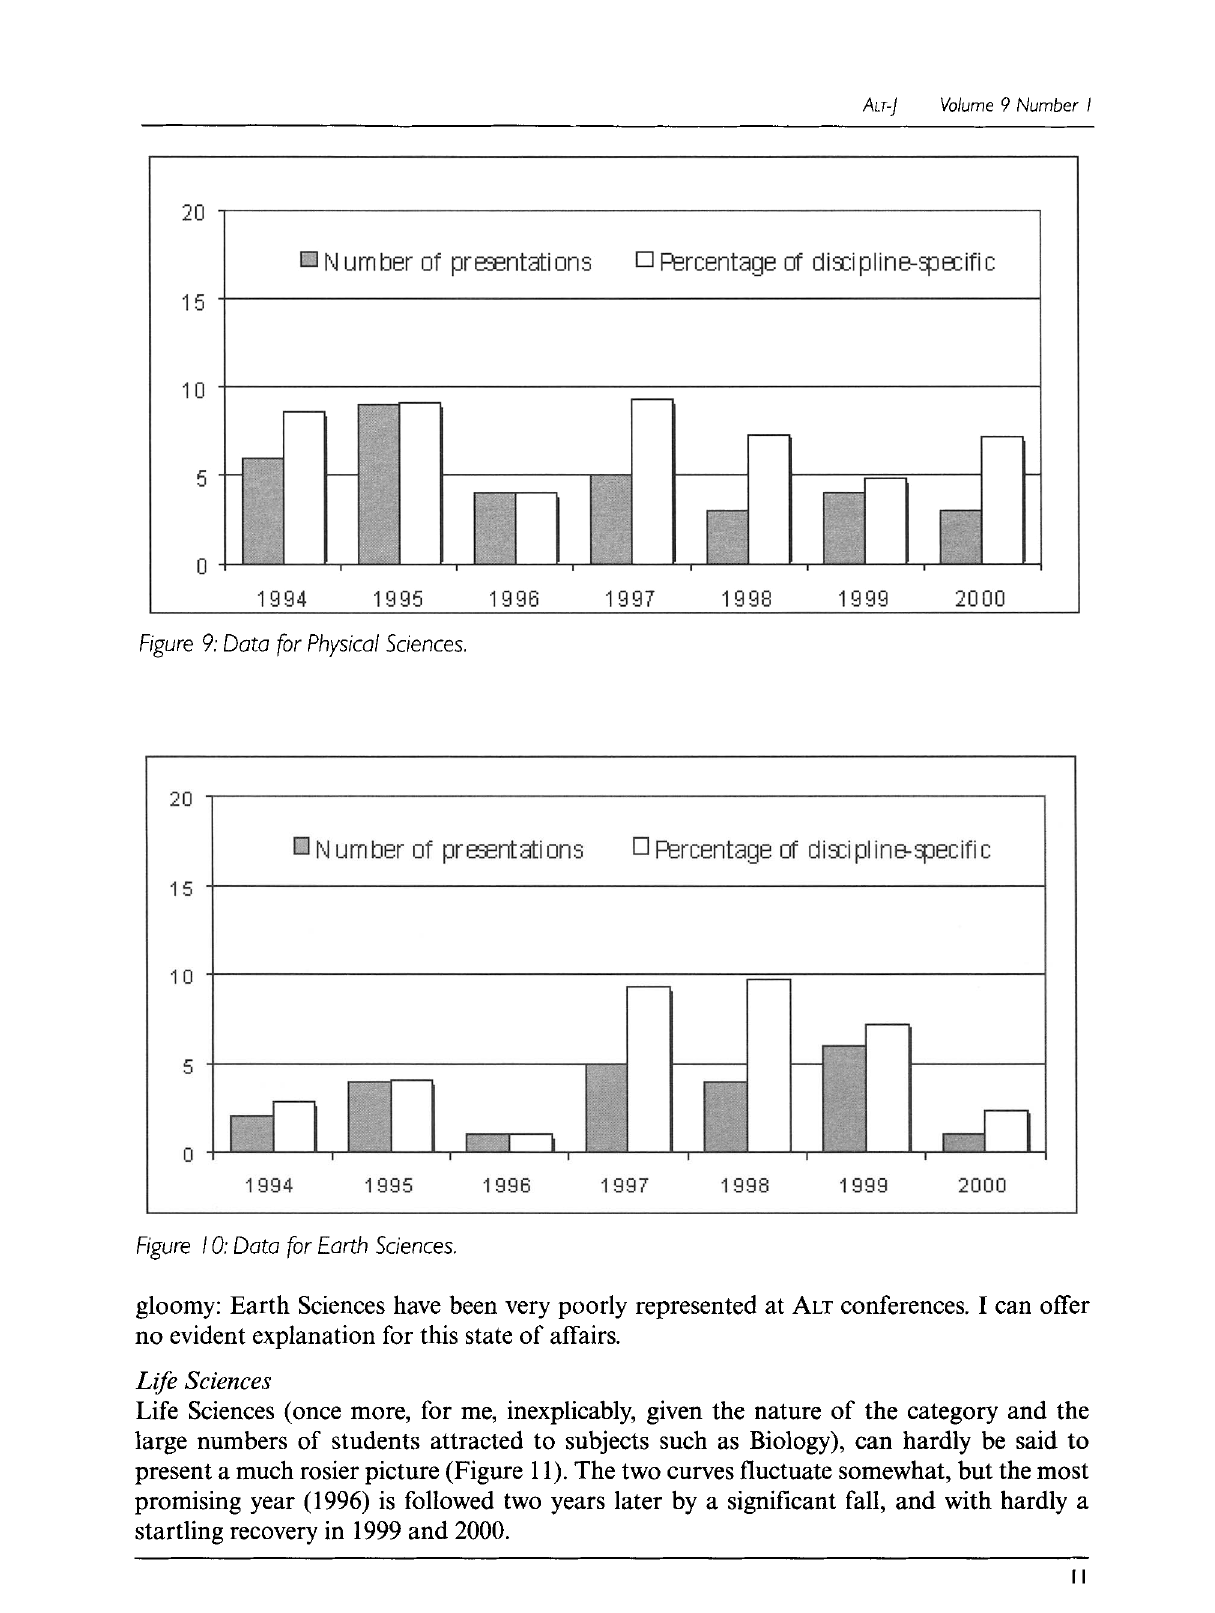
Figure 9: Data for Physical Sciences.